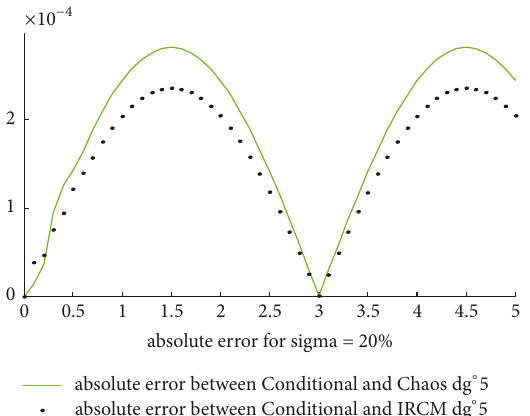
Figure 7: Absolute error between PC of degree 5 and IRCM of degree 5 and reference methods where 𝜉 0 and 𝜉 2 are truncated normal variables in [−4,4] , 𝜉 1 is a uniform variable in [−1, 1] , and 𝜉 3 is a truncated exponential variable in [0,10] and 𝜎 𝑖 = 20%.